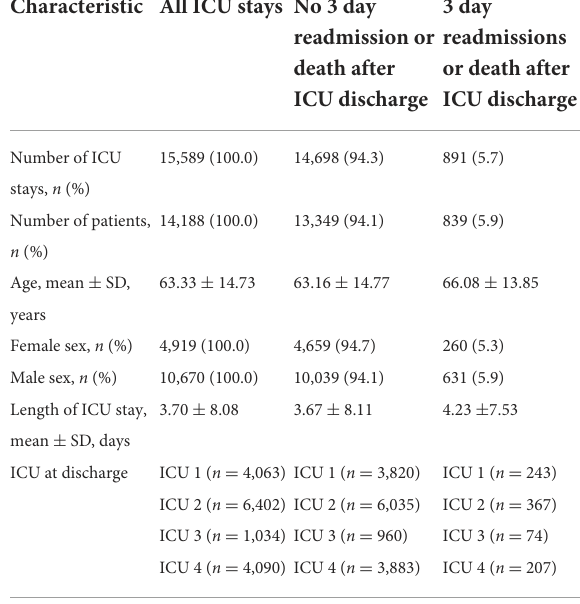
TABLE 1 Overview of the UKM